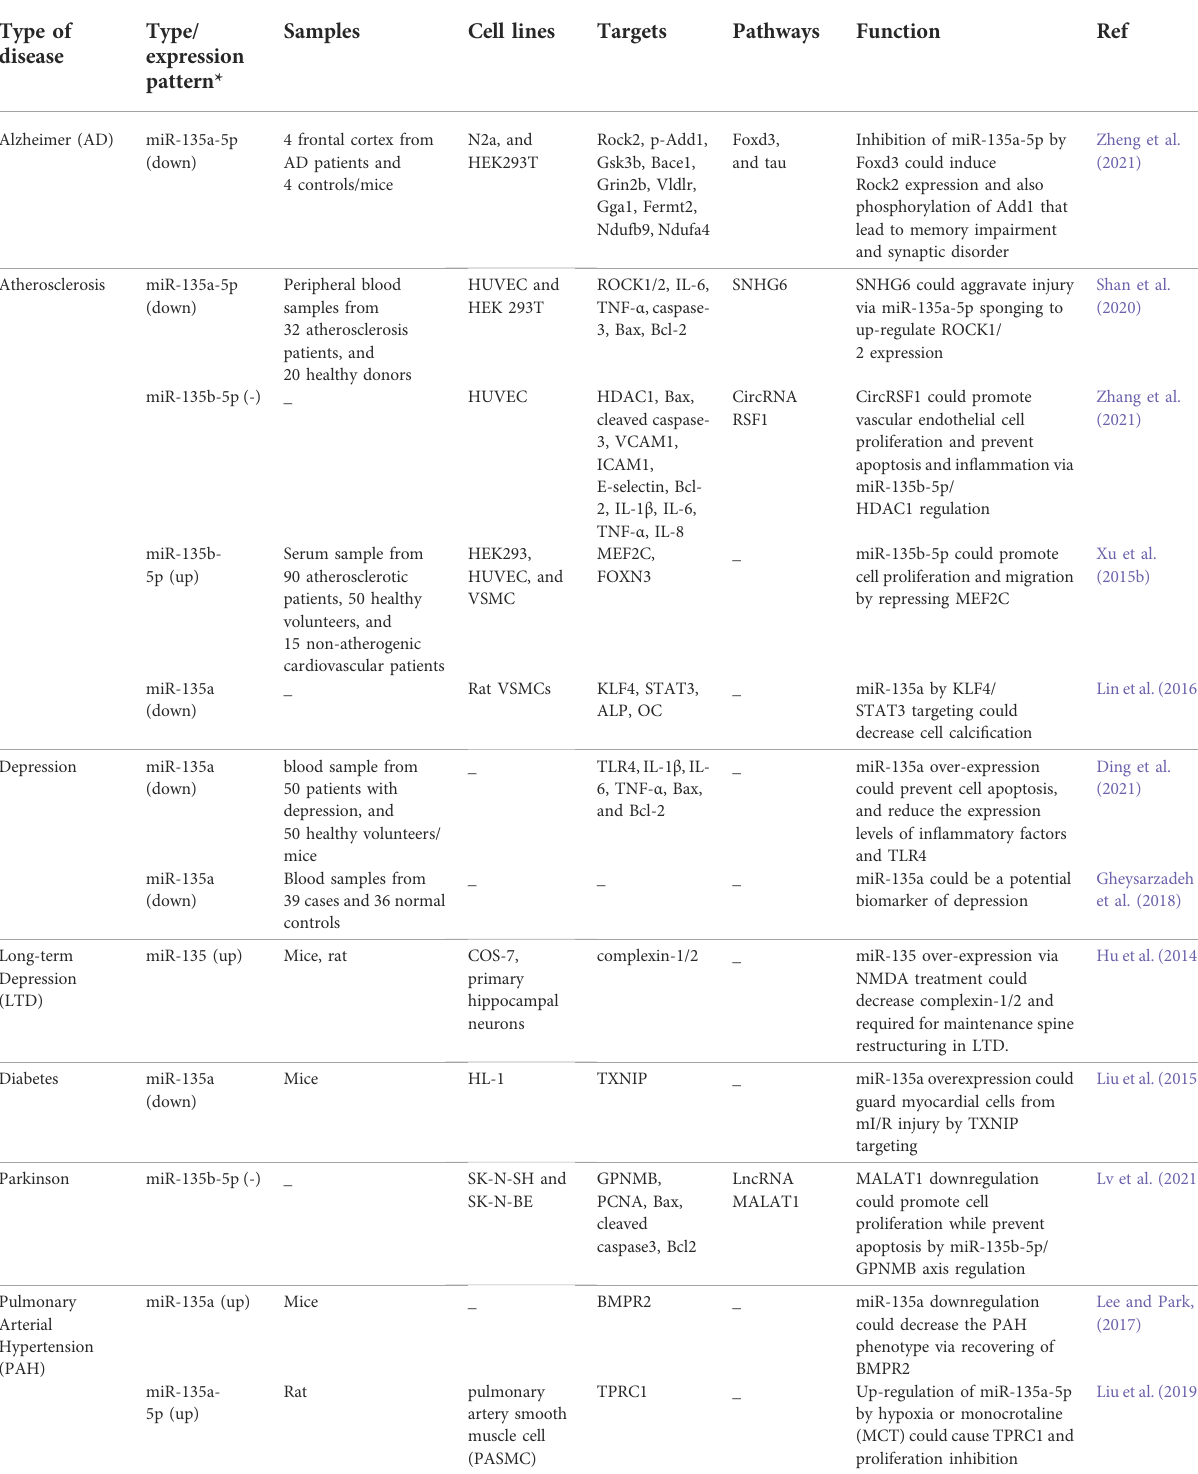
TABLE 3 miR-135 in non-cancerous